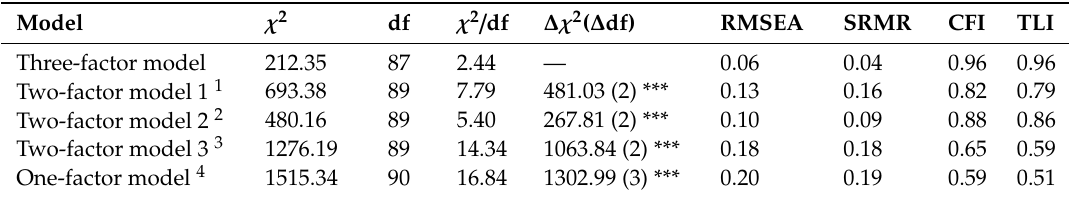
Table 1. Confirmatory factor analysis (CFA) results.